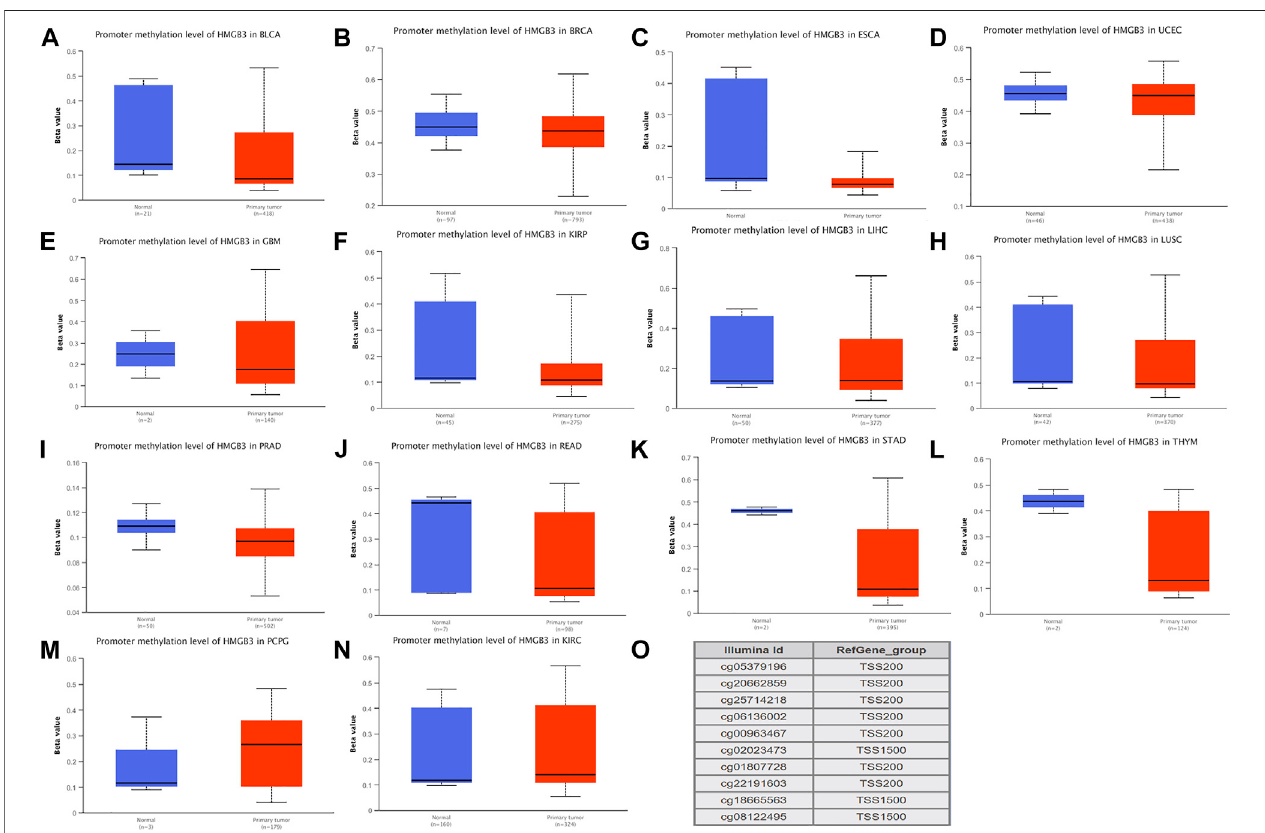
FIGURE 2 | DNA methylation aberration of HMGB3 in tumors. (A-L) Twelve highly HMGB3 express tumors presented with decreased DNA methylation level of HMGB3,includingBLCA,BRCA,ESCA,UCEC,GBM,KIRP,LIHC,LUSC,PRAD,READ,STAD,andTHYM.* p < 0.05.ThisdatawasobtainedusingUalcan. (M-N) Two HMGB3 downregulated tumor, PCPG and KIRC, presented increased DNA methylation level. * p < 0.05. This data was obtained using Ualcan. (O) Probes for detecting DNA methylation of HMGB3 promoter.